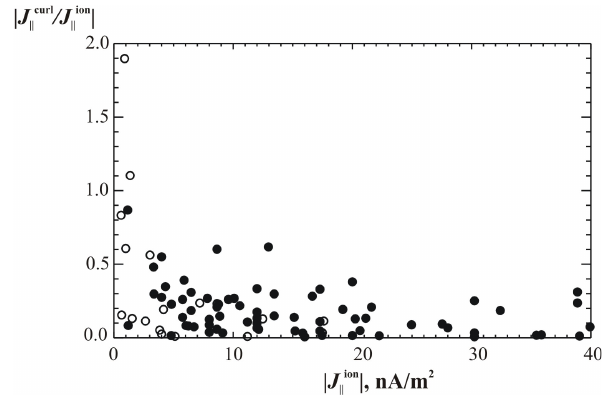
Fig. 11. Scatterplot of absolute values of the ratio of total current density ( ∇× B) || to the density of field-aligned current produced by high velocity ions ( J curl || / J ion || ) versus the absolute values of density of ion field-aligned current ( J ion || ) measured in each PSBL crossing from our data set. The PSBL crossings in which the parallel velocity of high-energy ions was less than the double value of local Alfv´en velocity are displayed by empty